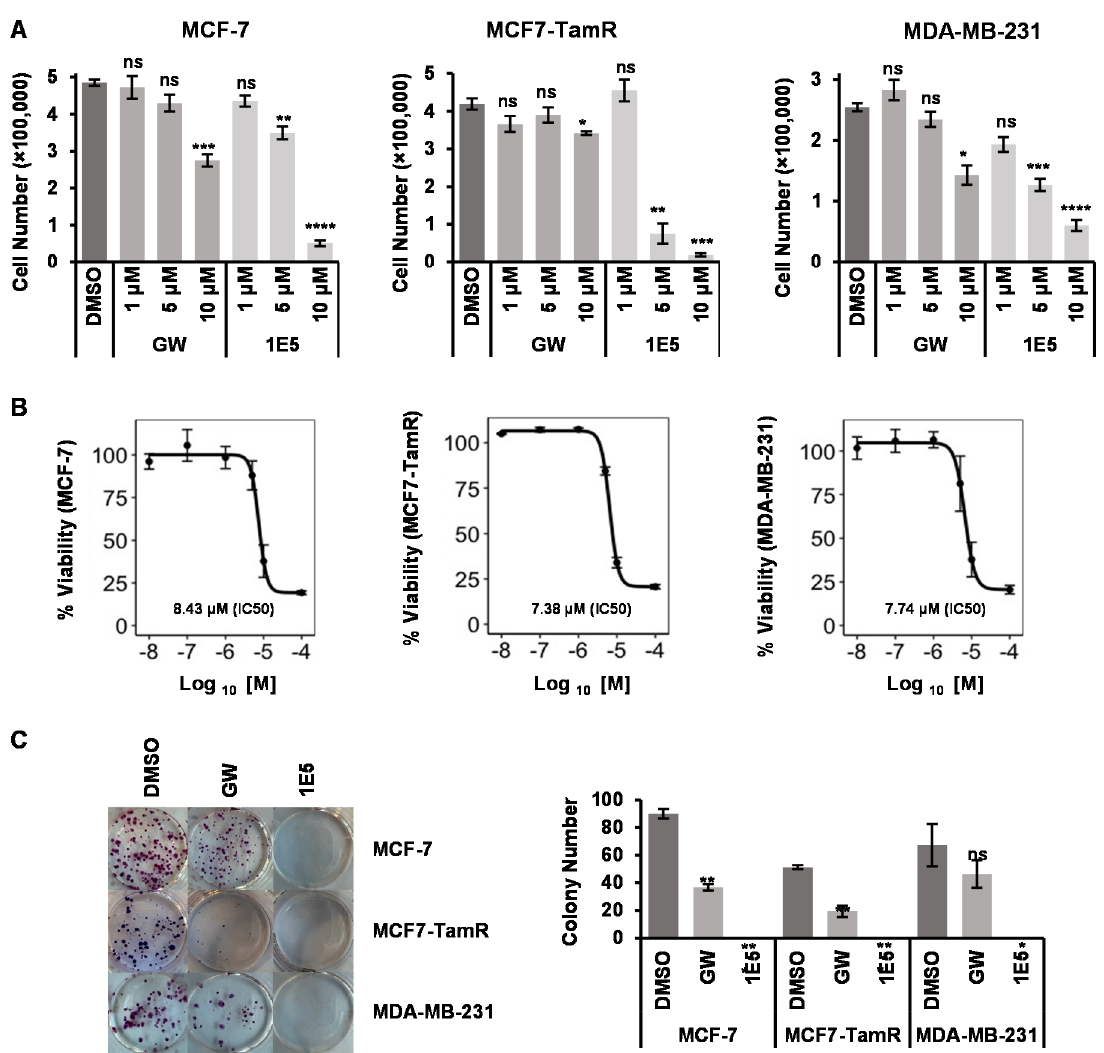
Figure 2. Novel LXR inverse agonist 1E5 disrupts cell proliferation in breast cancer cells in a concentration-dependent manner. ( A ) Trypan blue exclusion assay of breast cancer cell lines